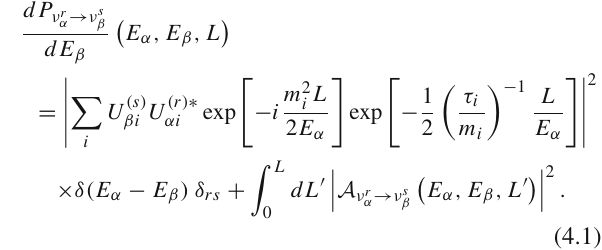
Fig. 1 The effective electron anti-neutrino disappearance probability as a function of anti-neutrino energy for the Daya Bay (top panel), JUNO (middle panel) and KamLAND (bottom panel) experiments. The left (right) panel is for the NO (IO). We show the effective probabilities (defined as the ratio of the ν e flux arriving at the detector divided by the original flux at the detector in the absence of oscillation for a given neutrino energy) assuming standard oscillations without any decay (labeled “osc. w/o decay” in blue), with visible decay effect but without the daughter neutrino contribution (labeled “decay w/o app” in red) and with visible decay including the daughter neutrino contribution (labeled “decay w app” in black). For the visible decay, we consider g S = g PS = 0 . 2 for NO and g S = g PS = 0 . 1 for IO.